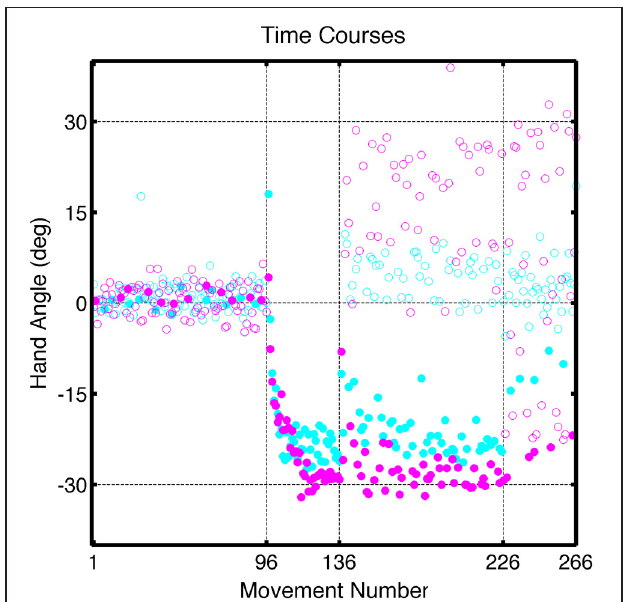
FIGURE 6 | Group averaged endpoint hand angle across trials in Experiment 2. Block structure was the same as in Figure 2 . Filled circles represent movements to the training target location and open circles represent movements to other target locations (cyan: CircleTranslation group; purple: LineRotation